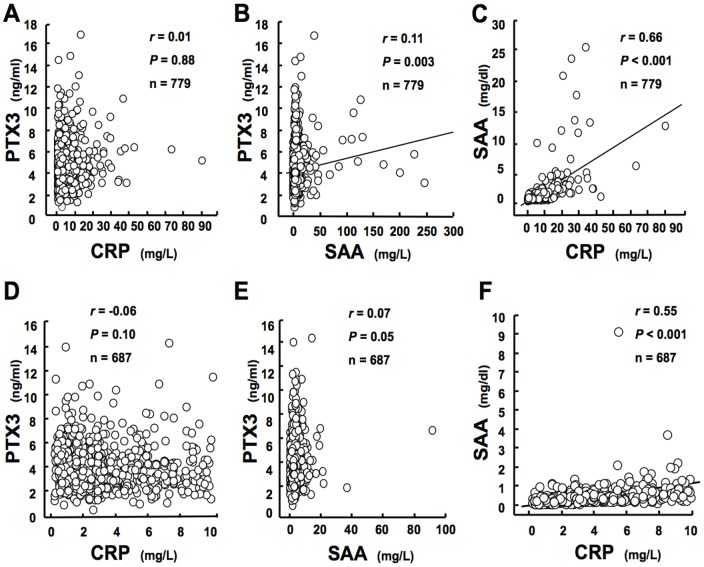
Lack of association between PTX3 and short pentraxin.Spearman correlations revealed no association between plasma levels of the long pentraxin PTX3 and the short pentraxin CRP (A). Plasma PTX3 levels positively correlated with plasma SAA levels (B), and plasma CRP and SAA levels correlated strongly with each other (C). After exclusion of participants with high CRP levels (>10 mg/L), PTX3 showed no significant correlations with CRP and SAA (D and E), whereas CRP and SAA correlated positively with each other (F).